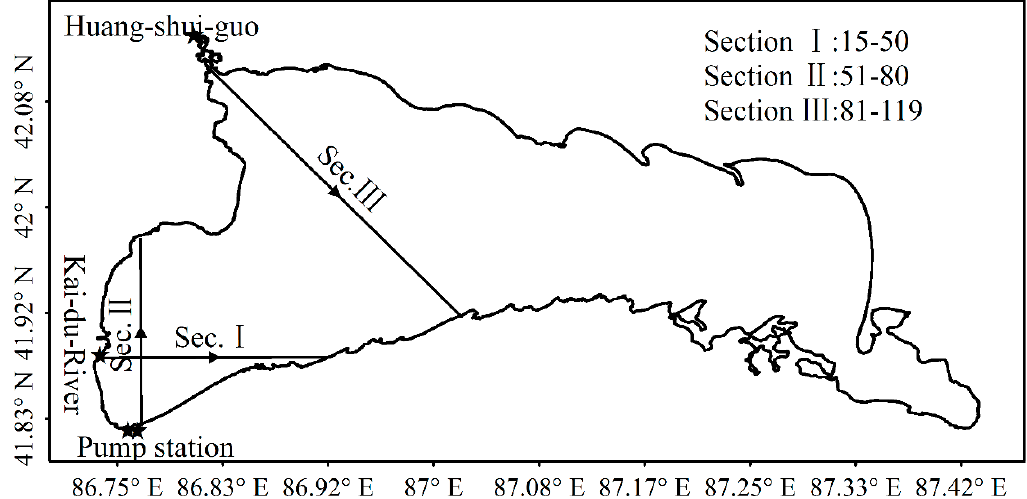
Figure 9. The three sections of Sec.I, Sec.II, and Sec.III were selected to show salinity changes in the sensitivity experiments. The arrows show the direction of the sections.